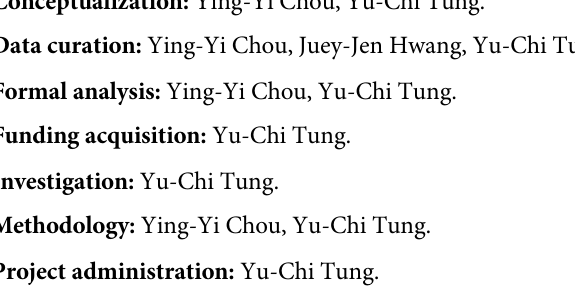
S1 Table. Area under curve for various cut points of hospital volume. S2 Table. Area under curve for various cut points of surgeon